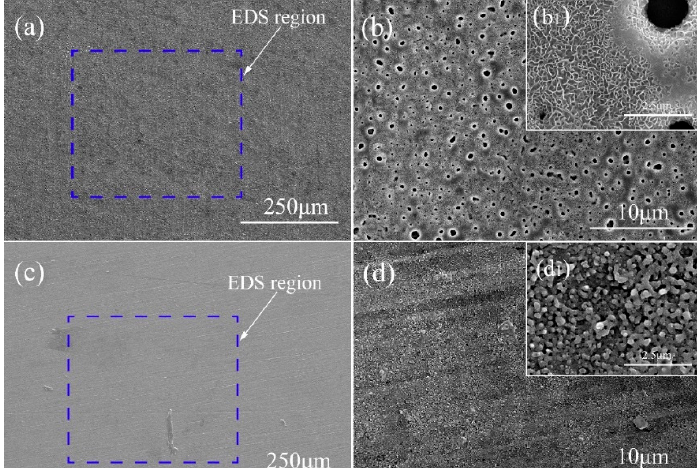
Figure 3. Morphologies of PEO-coated AZ31 magnesium alloy. ( a ) Surface morphologies of P-coating, ( b ) enlargement of framed region in ( a ), ( c ) surface morphologies of F-coating, ( d ) enlargement of framed region in ( c ).